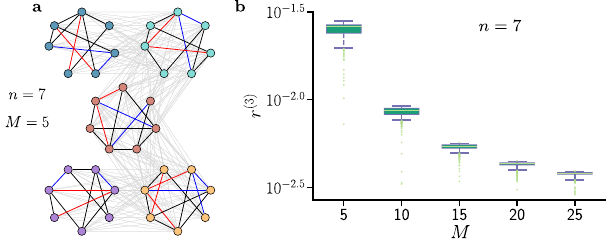
Fig. 5 Complexity reduction in the analysis of synchronization patterns in temporal networks. a Example of a temporal network consisting of M = 5 clusters, each with n = 7 nodes. In each cluster, an expected 20% of the links are temporal (connections alternate between the blue and the red links) and the remaining 80% are static (black links). Two clusters are either all-to-all connected (gray lines) or fully disconnected. b Reduction in computational complexity achieved by the SBD algorithm for cluster size n = 7, intracluster link density p = 0.5, and intercluster link density q = 0.5 as the cluster number M is varied. The box covers the range 25th – 75th percentile, the whiskers mark the range 5 th – 95 th percentile, and the dots indicate the remaining 10% outliers. Each boxplot is based on 1000 independent network